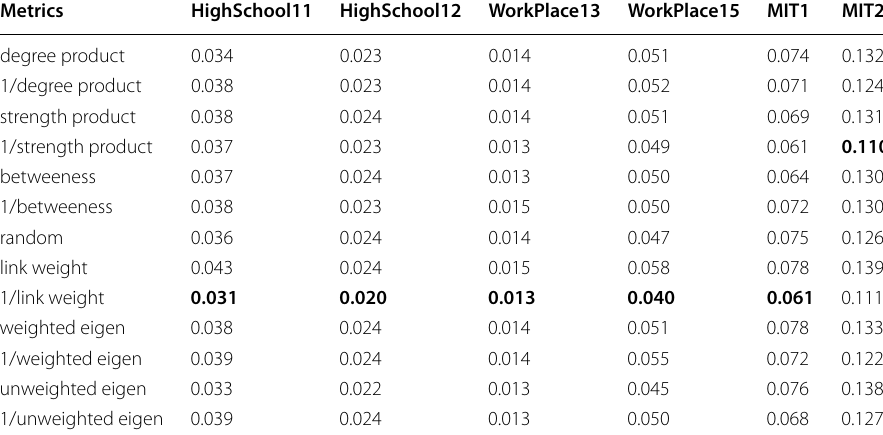
The lowest average prevalence value for each dataset is highlighted in bold